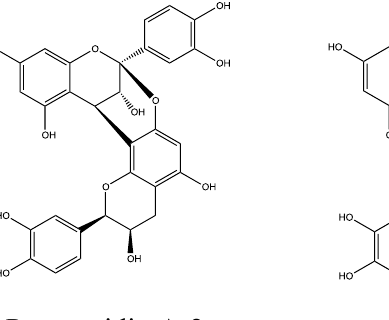
Procyanidin A-2 Ixoratannin A-2 Cinnamtannin